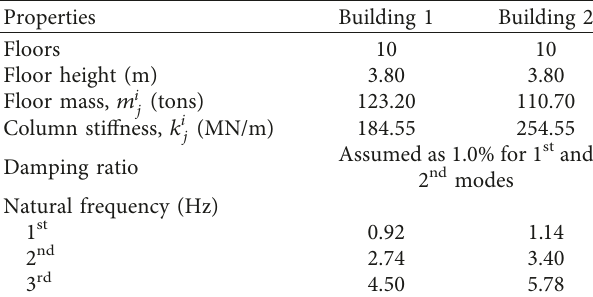
Table 1: Dynamic properties of two building